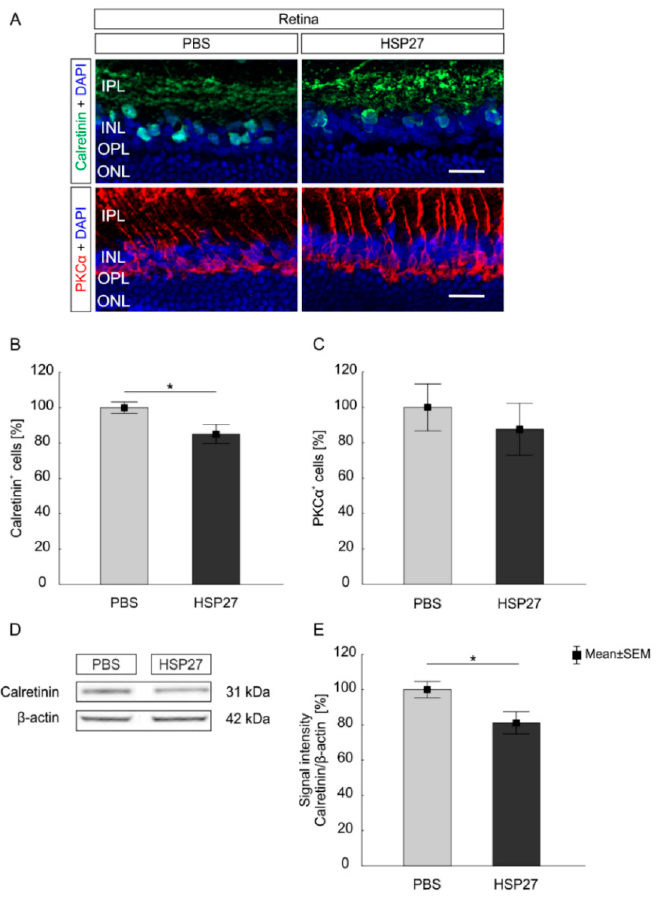
Figure 3. Degeneration in the inner retina layer. ( A ) The amacrine and bipolar cells were stained with the antibody calretinin (green) and PKC α (red). 4’,6-Diamidin-2-phenylindol (DAPI; blue) was used to label cell nuclei. ( B ) Fewer calretinin + amacrine cells were noted in the HSP27 group ( p = 0.038). ( C ) The number of bipolar cells was similar in both groups ( p > 0.05). ( D ) Calretinin (55 kDa) was analyzed via western blot using β -actin (42 kDa) for normalization at day 21. ( E ) A lower calretinin level was detected in the HSP27 group compared to the PBS group ( p = 0.031). IPL = inner plexiform layer, INL = inner nuclear layer, OPL = outer plexiform layer, ONL = outer nuclear layer, scale bar = 20 µ m, n = 6 / group (immunohistology and western blot), * p <